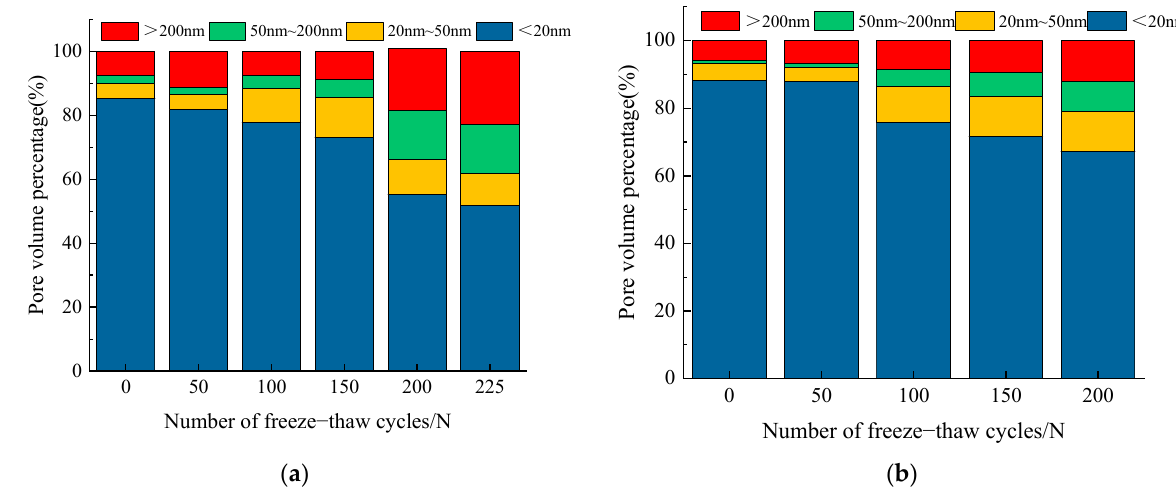
Figure 17. Pore size distribution of concrete with different w/c ratios after freezing–thawing damage. ( a ) w/c = 0.45; ( b ) w/c = 0.55.